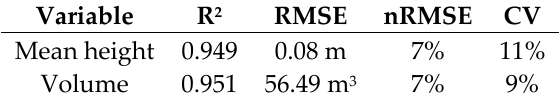
Table 1. Estimate results (R 2 : coefficient of determination; RMSE: root mean square error; nRMSE: normalized RMSE; and CV: coefficient of variation) from the characterization of the understory